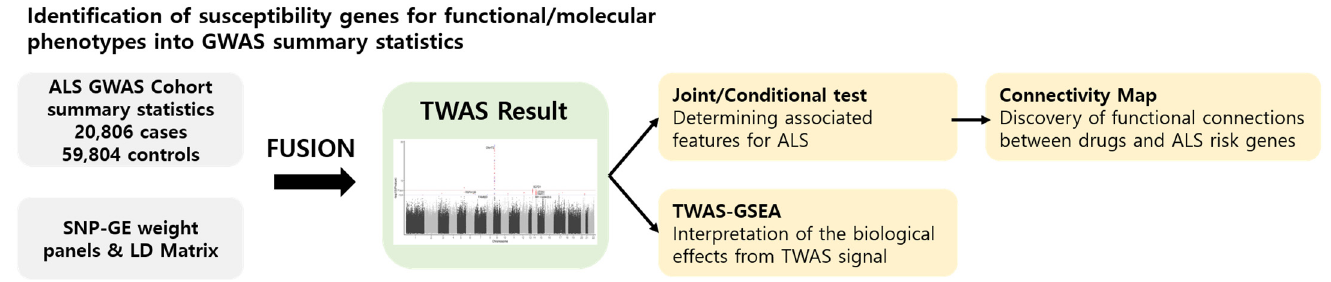
Figure 1. Analytical workflow.